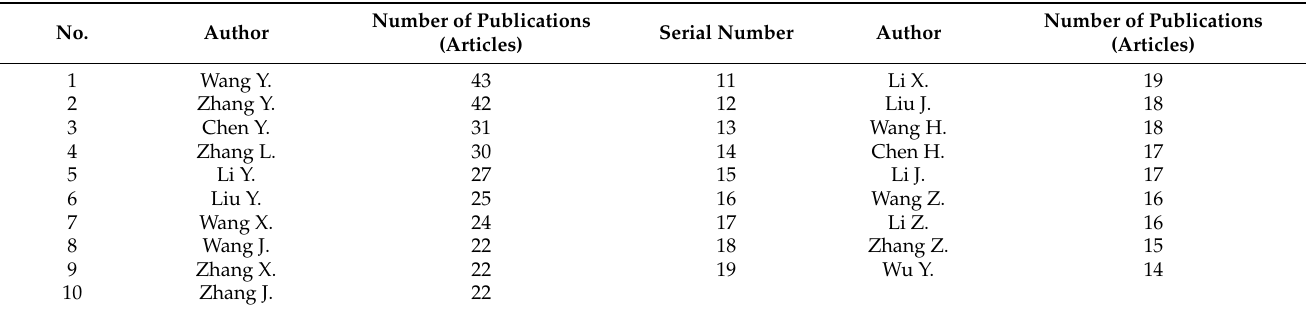
Table 5. Statistics for high-frequency authors of rural human settlements research.